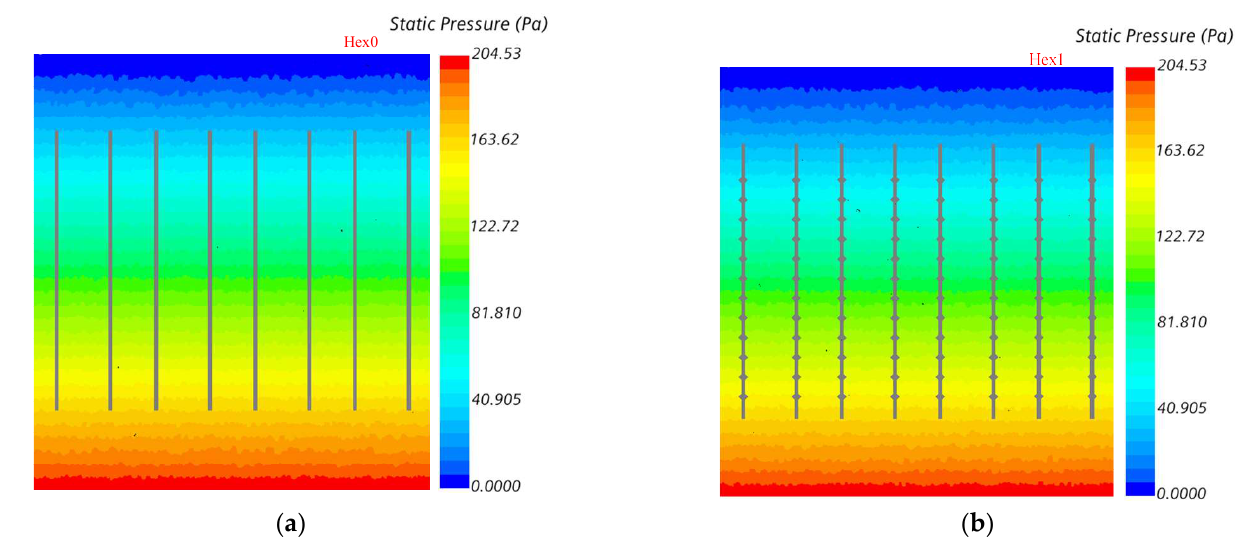
Figure 10. Static pressure comparison between ( a ) Hex0 and ( b ) Hex1.